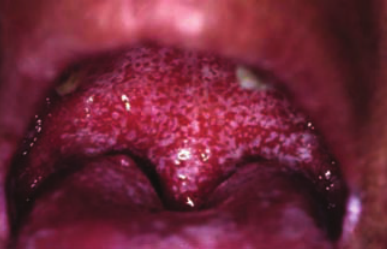
Figure 1. Oral pseudomembranous can- didiasis. 8 Reproduced with permission from IAS-USA. Top HIV Med 2005;13: 143-8.